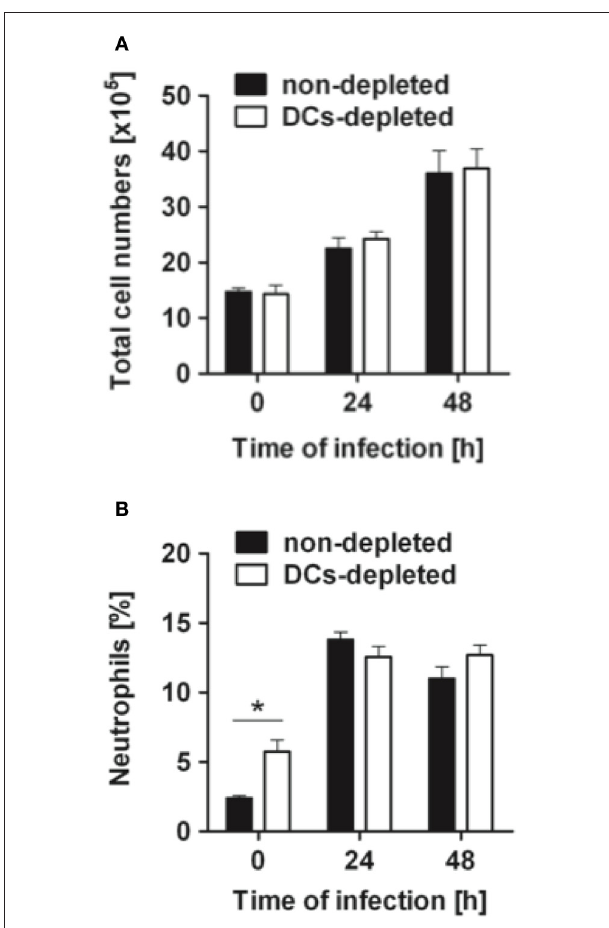
FIGURE 4 | Cell recruitment in the lungs of DCs-depleted and non-depleted mice during pneumococcal pneumonia. DCs-depleted (white bars) and non-depleted (black bars) CD11c-DTR chimera mice were intranasally infected with 1 × 10 8 CFU of S. pneumoniae D39, the lungs taken before (0 h) or at 24 and 48h after bacterial inoculation and dispersed with collagenase and DNase to obtain a single cell suspension. Cells were counted (A) and then stained with antibodies against Gr-1 to identify the neutrophil population (B) by flow cytometry analysis. Each bar represents the mean ± SD of triplicate samples. One representative experiment out of three is shown. ∗ p < 0 .